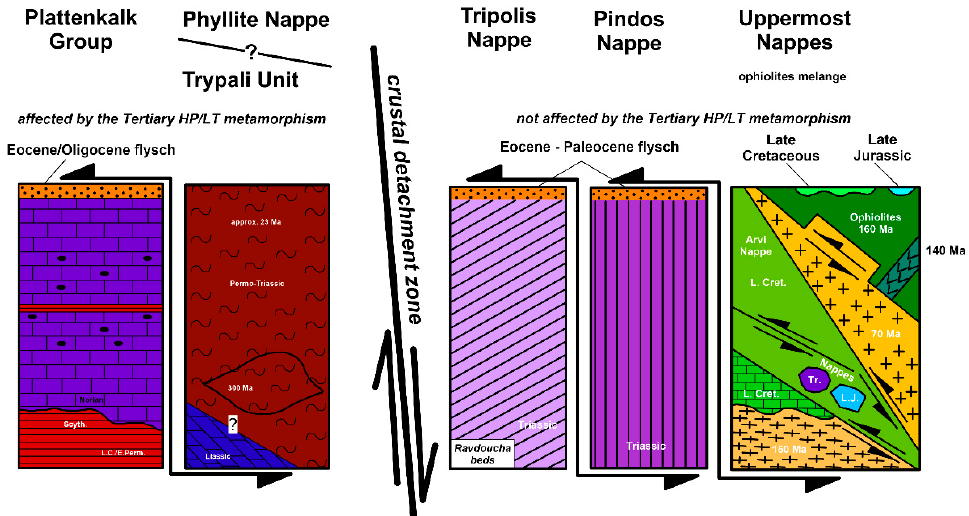
Figure 1. Tectonic emplacement of the tectonostratigraphic units and nappes of Crete (modified from Seidel et al. [23]).